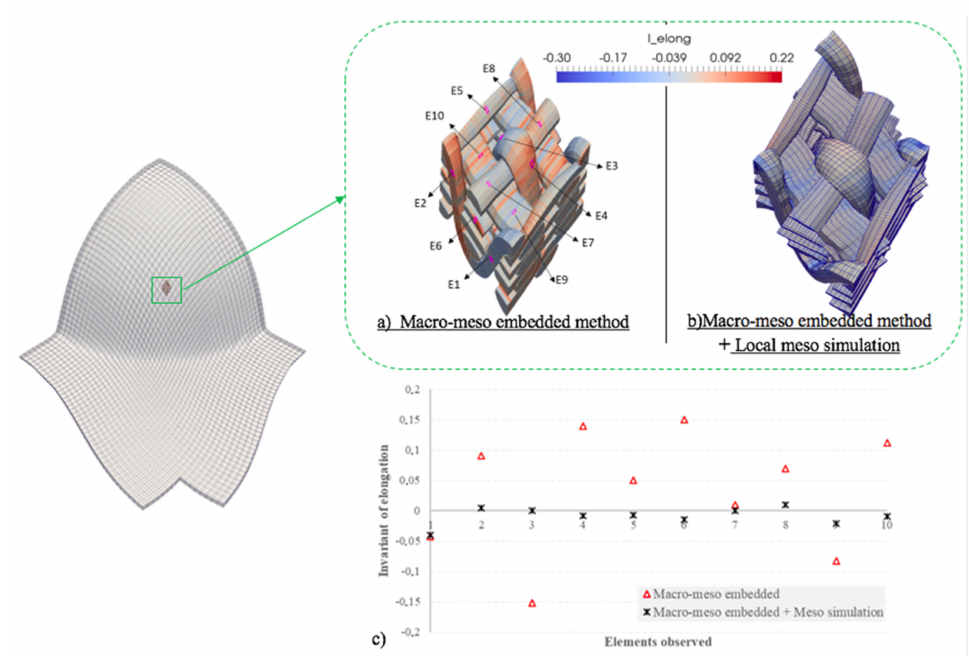
Figure 8. Influence of the enriched local mesoscopic simulation on the elongation of yarns in hemispherical forming. ( a ) Macro-meso embedded analysis. ( b ) Macro-meso embedded method with local mesoscopic simulation analysis. ( c ) Change in elongation for the same elements.